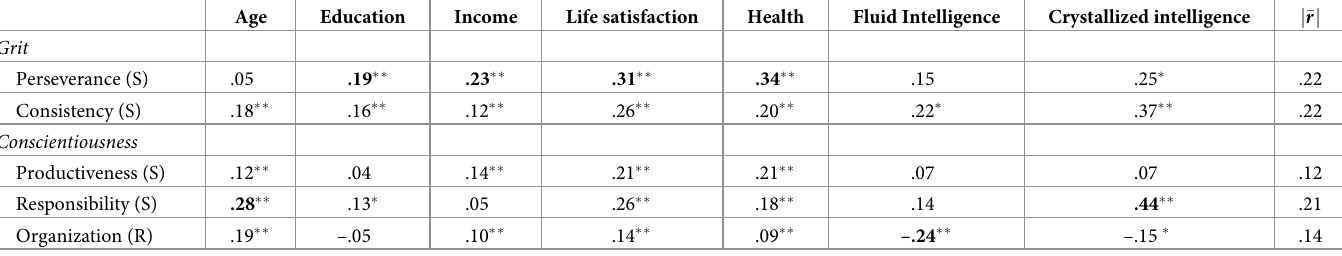
Table 5. Correlations with age, education, income, life satisfaction, health, and fluid and crystallized intelligence for Model B (organization as a reference